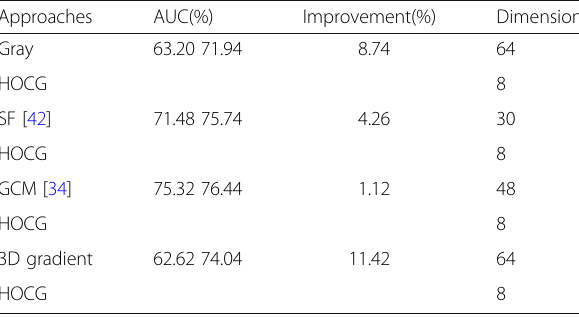
Table 2 Performance comparisons between the HOCG descriptors and its based regional